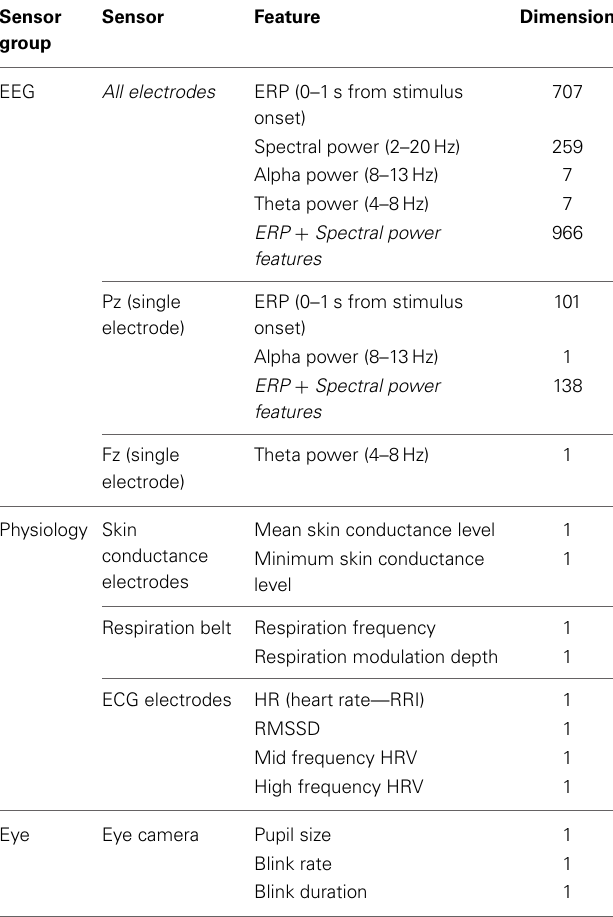
Table 1 | Examined (neuro)physiological features, sensors and sensor